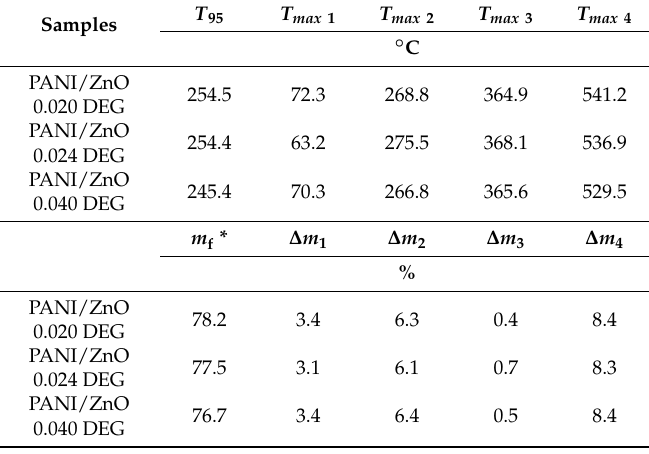
Table 3. Data obtained from thermal analysis of PANI/ZnO composites: T 95 and T max 1,2,3,4 , weight loss for each specific temperature region ( ∆ m 1,2,3,4 ), and the chair residue ( m f ).